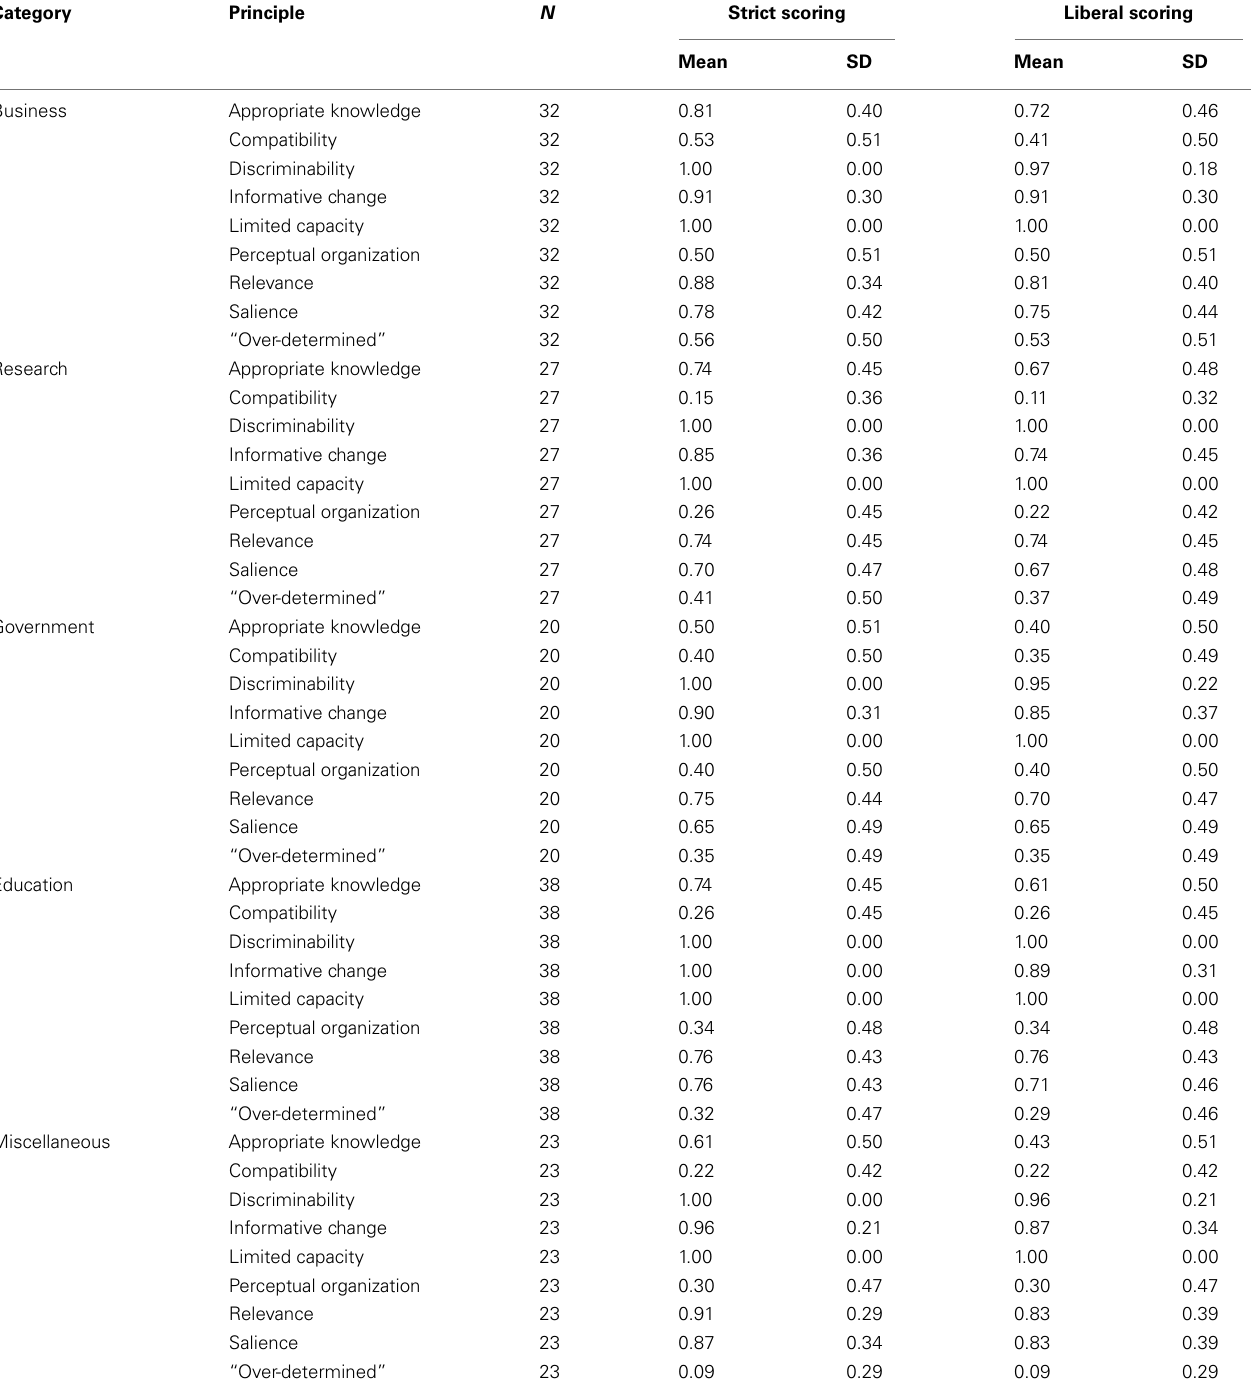
Table 2 | Proportion of violations for each principle in each category for Study